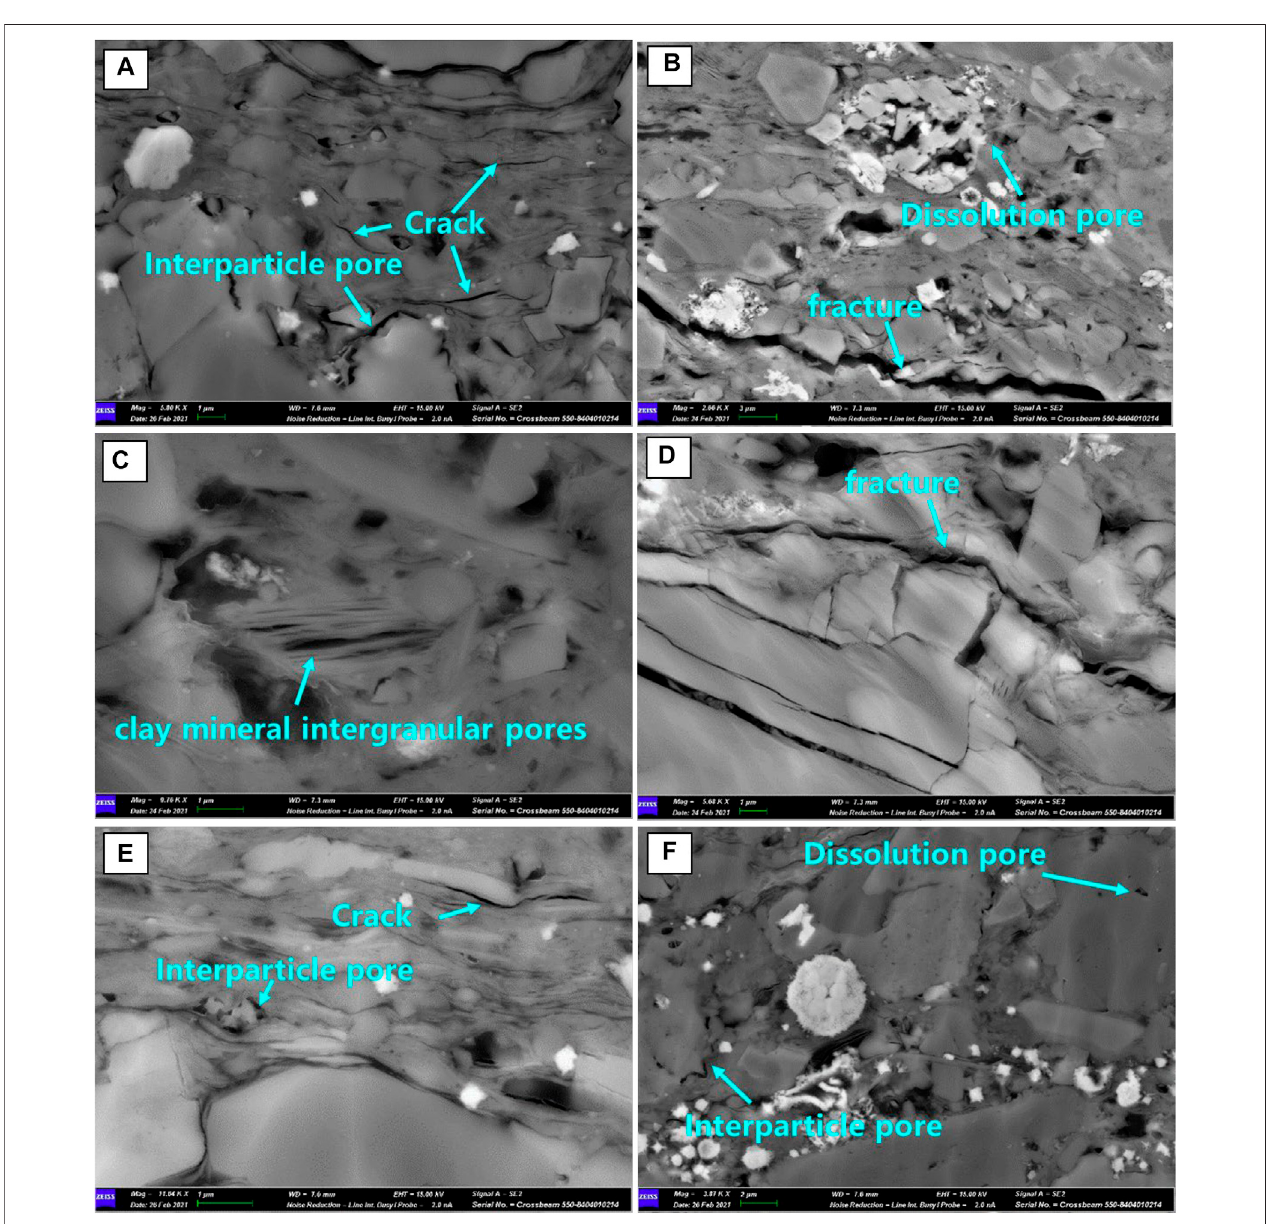
FIGURE 9 | Morphology and distribution of various inorganic pores developed in the Shahejie Shale: (A) Sample 2, 3784.25 m; (B) Sample 3, 3784.60 m; (C) Sample 3, 3784.60 m; (D) Sample 5, 3785.12 m; (E) Sample 6, 3785.43 m; (F) Sample 6, 3785.43 m.